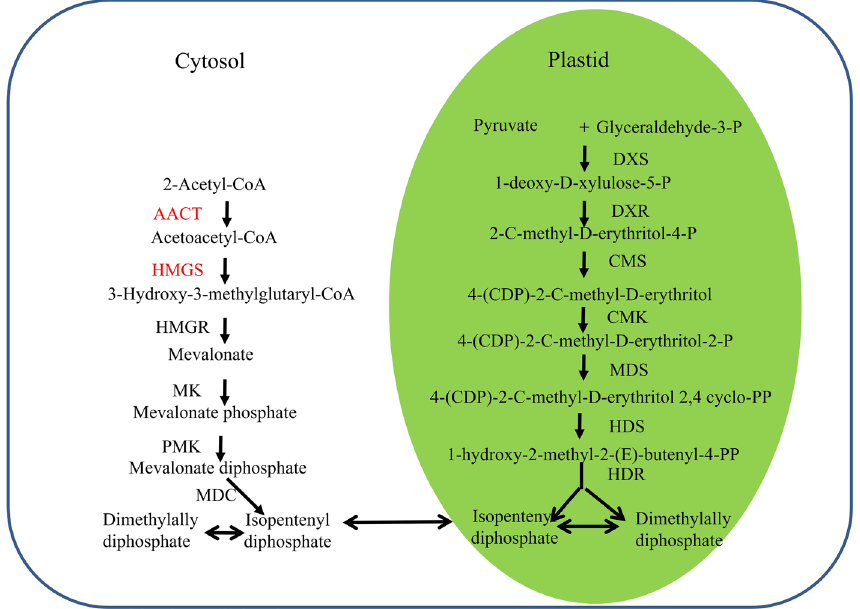
Figure 1. Pathway of isoprenoids biosynthesis in plants (DXS, 1-deoxy-Dxylulose-5-phosphate synthase; DXR, 1-deoxy-D-xylulose-5-phosphate reductoisomerase; CMS, 4-diphosphocytidyl-2-C-methyl-D-erythritol synthase; CMK, 4-diphosphocytidyl-2-C-methyl-D-erythritol kinase; MDS, 2-C-methyl-D-erythritol 2,4-cyclodiphosphate synthase; HDS, 4-hydroxy-3-methylbut-2-enyl diphosphate synthase; HDR, 4-hydroxy-3- methylbut-2-enyl diphosphate reductase). The Figure was drawn by ourselves after referring to previous studies (Laule et al. 2003; Miziorko et al. 2011; Tholl et al. 2015) and tagged the genes marked red were